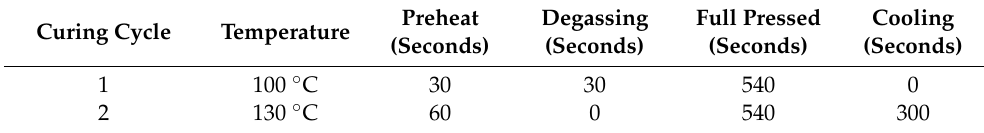
Table 1. Curing cycle of carbon fibre glass fibre and hybrid fibre in compression moulding. Table 3. Flexural loading for cyclic testing in N. With carbon fibre ply’s labelled with C and glass fibre ply’s labelled G the inclusion of veil toughening is labelled with a T .